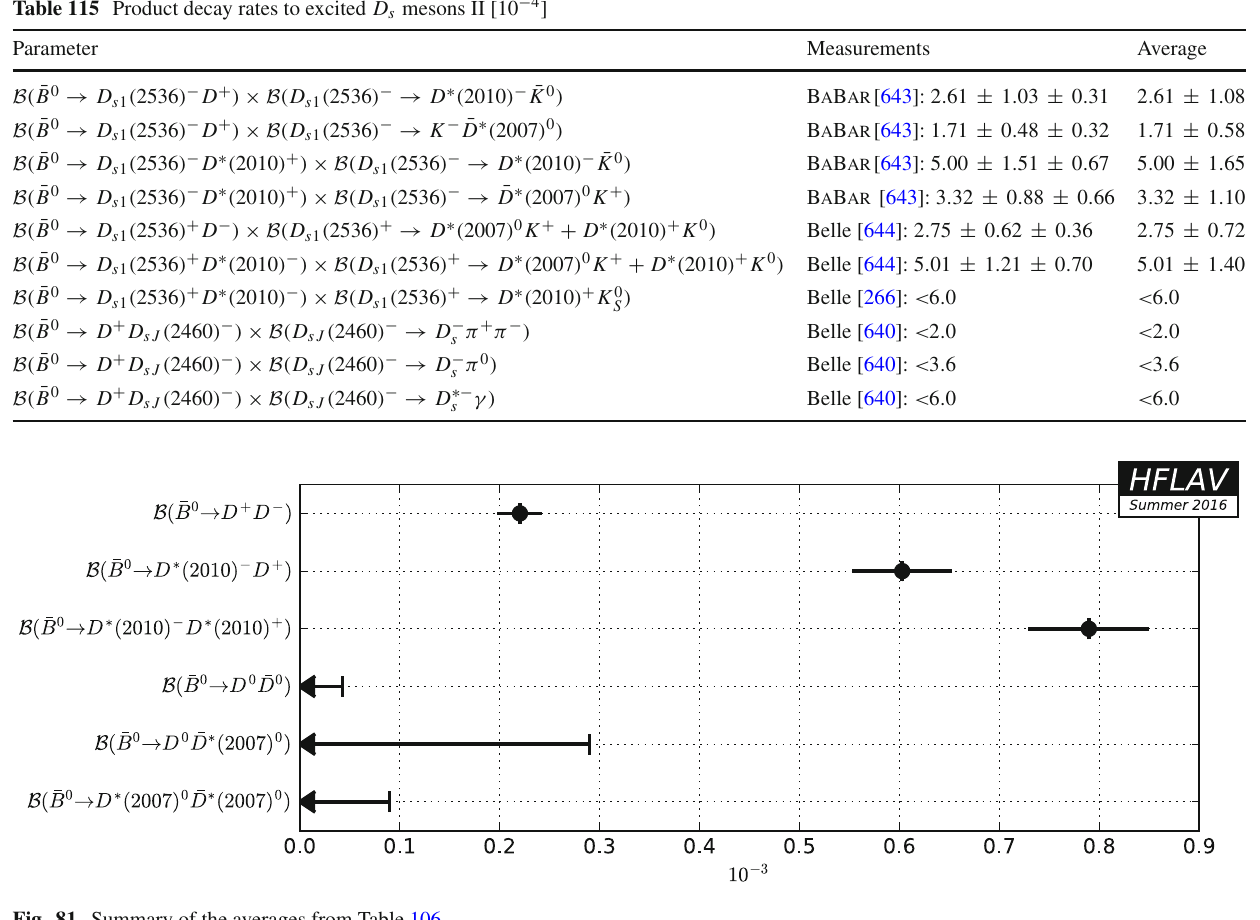
Fig. 81 Summary of the averages from Table